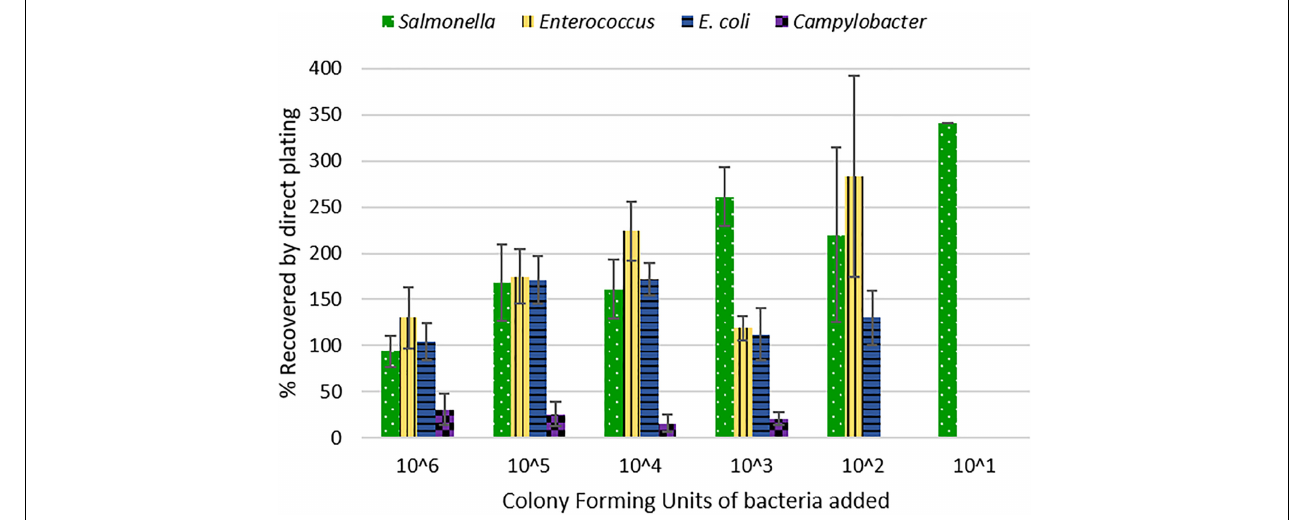
FIGURE 1 | Percent of bacterial inocula recovered from